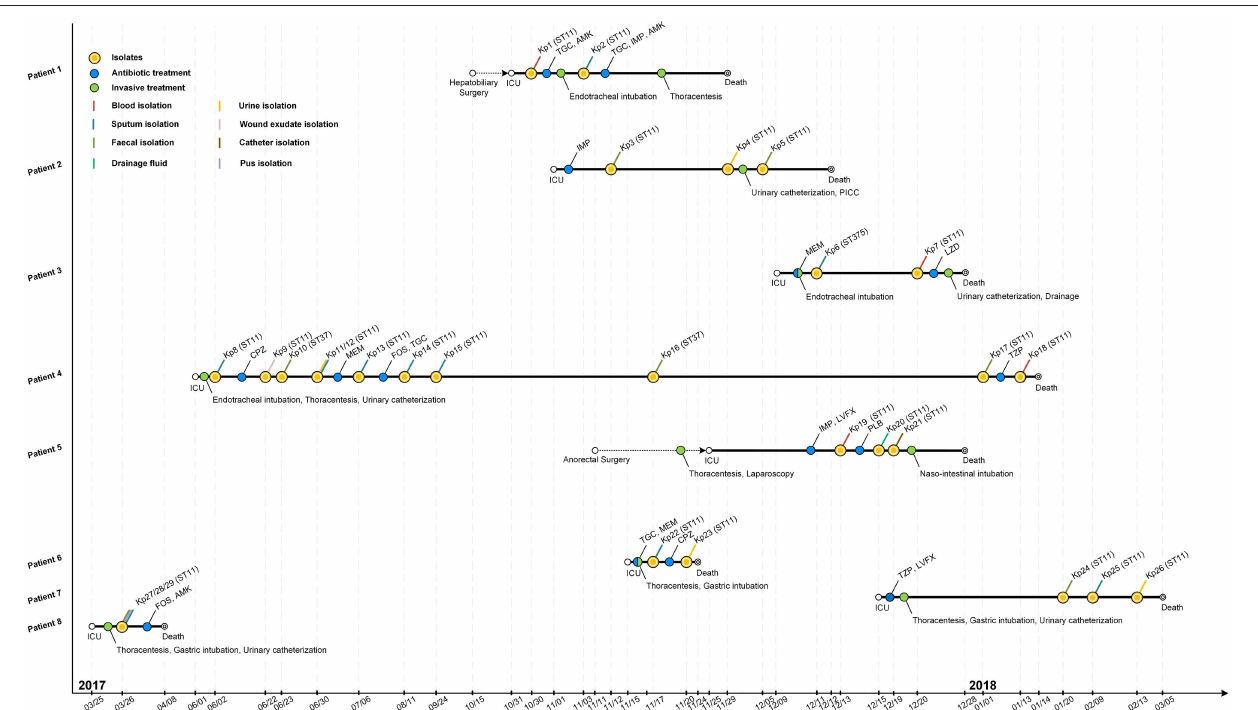
FIGURE 1 | Epidemiology of the K. pneumoniae outbreak cases. Each horizontal line represents the timeline of one patient, with respect to treatments and isolation of tissue or fluid samples, with the abscissa axis showing the relevant dates. Isolates and the treatments of those patients are shown by colored dots. Different specimens are shown by colored lines. TGC, tigecycline; AMK, amikacin; IMP, imipenem; MEM, meropenem; LZD, linezolid; CPZ, cefoperazone; FOS, fosfomycin; TZP, piperacillin-tazobactam; LVFX, levofloxacin; PLB, polymyxin B; PICC, peripherally inserted central